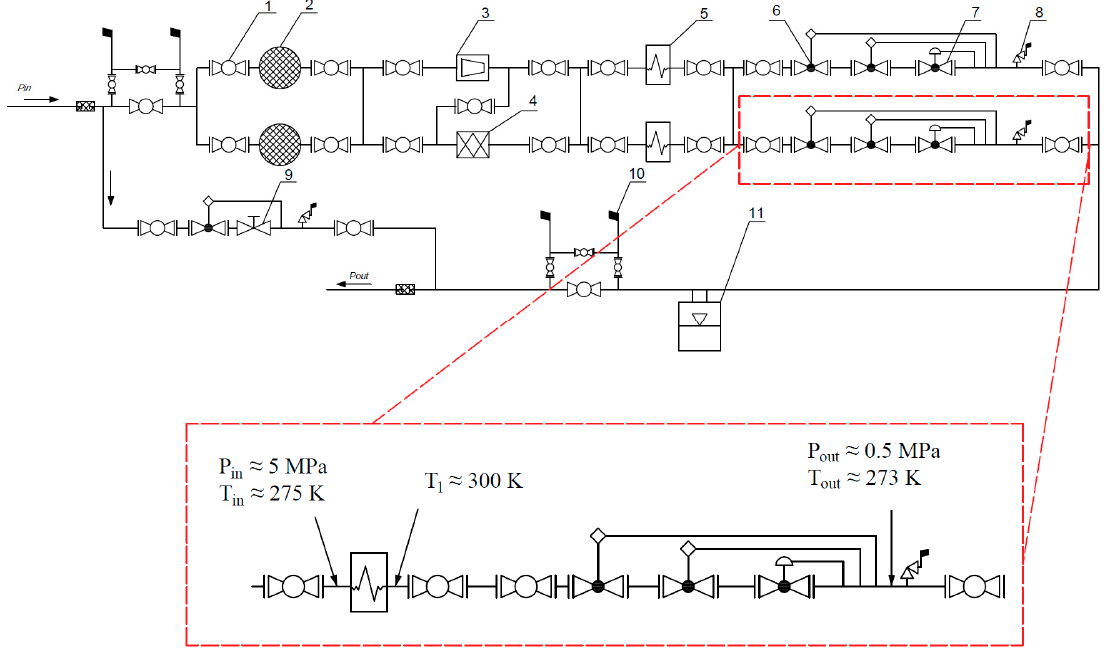
Figure 1. Scheme of the natural gas Reducing and Metering Station (without turboexpander). 1—